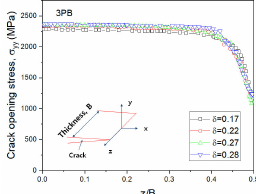
Figure 10. Variation of opening stress with the thickness for 3PB specimen.